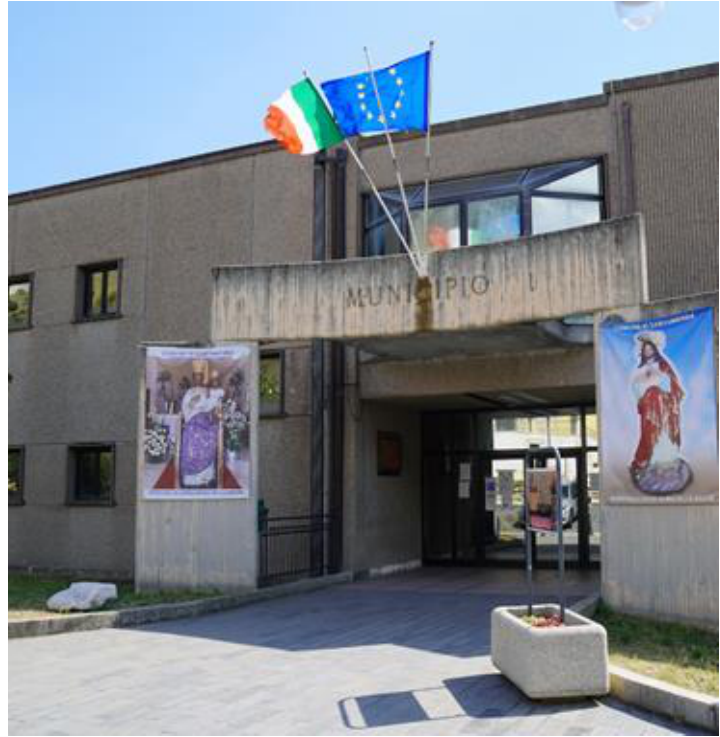
Figure 32. Santomenna: the new Town Hall in reinforced concrete (photos by [35,36]).